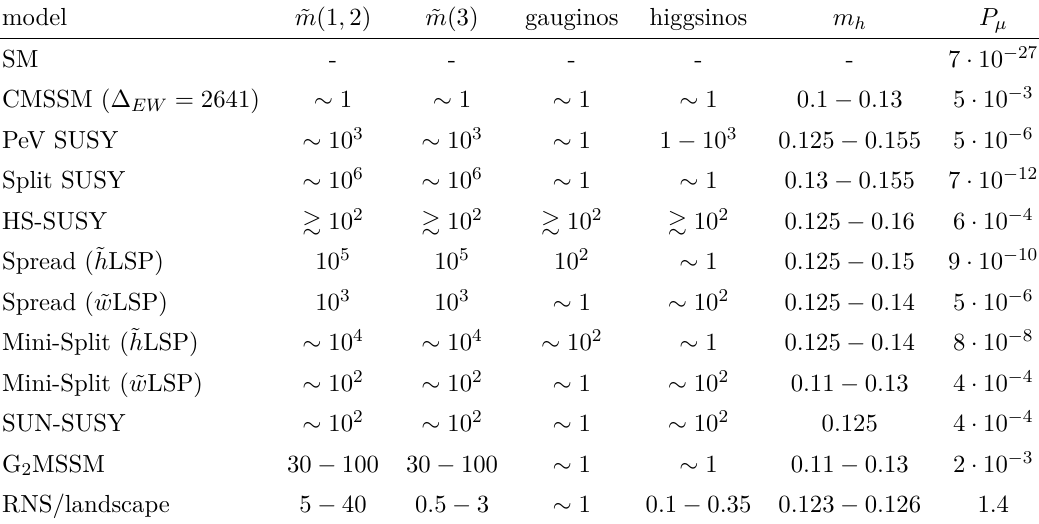
Table 1 . A survey of some unnatural and natural SUSY models along with general expectations for sparticle and Higgs mass spectra in TeV units. We also show relative probability measure P µ for the model to emerge from the landscape. For RNS, we take µ min = 10